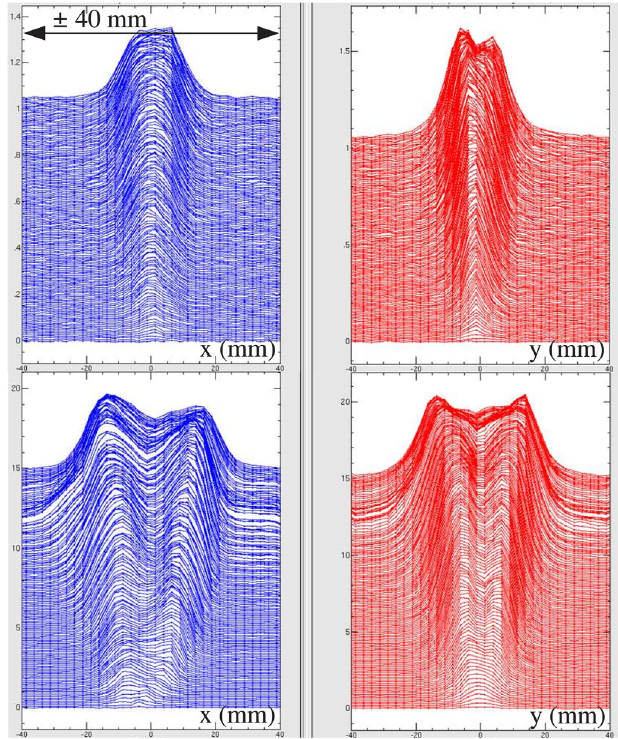
FIG. 29. (Color) Horizontal (left) and vertical (right) beam profile mountain views measured over the injection period (0.5 ms) with IPM, where the upper ones show those for the center injection, and the lower ones are with the transverse beam painting (correlated painting). The painting emittance was set at 150 (cid:3) mm mrad for both the horizontal and vertical planes.